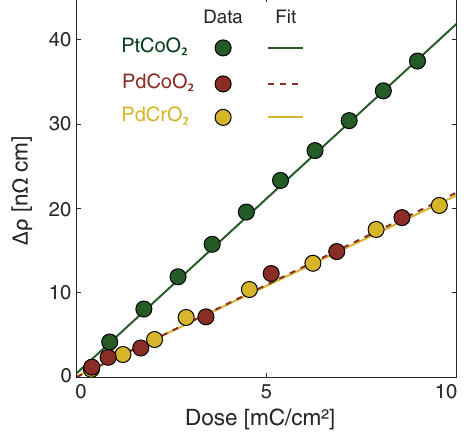
FIG. 6. Increase of resistivity as a function of electron dose for three delafossite metals: PtCoO 2 , PdCoO 2 , and PdCrO 2